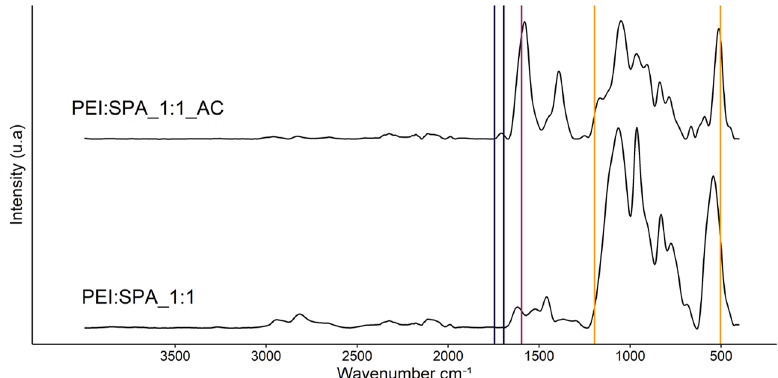
4 Figure 4. FTIR spectra of PEC_1:1 pre- and post-acidification. The spectra of the acidified PECs of different ratios are compared in Figure 5. It is interesting to note that the peak shift around 1580 cm − 1 is conditioned by the PEI:SPA ratio, as described in Table 2. The shift is greater when a higher proportion of SPA is used, which suggests that the polyelectrolytes’ interactions are stronger and the PECs are probably more likely to be stable in solution. In addition, a shift of the 504 cm − 1 peak and the disappearance of the 1196 cm − 1 one, corresponding to PO 43 − , are also observed, which confirm greater interaction between PO 43 − and protonated NH 2 . Finally, as is described in the literature, a band appears around 1390 cm − 1 , resulting from the interaction between SPA and PEI